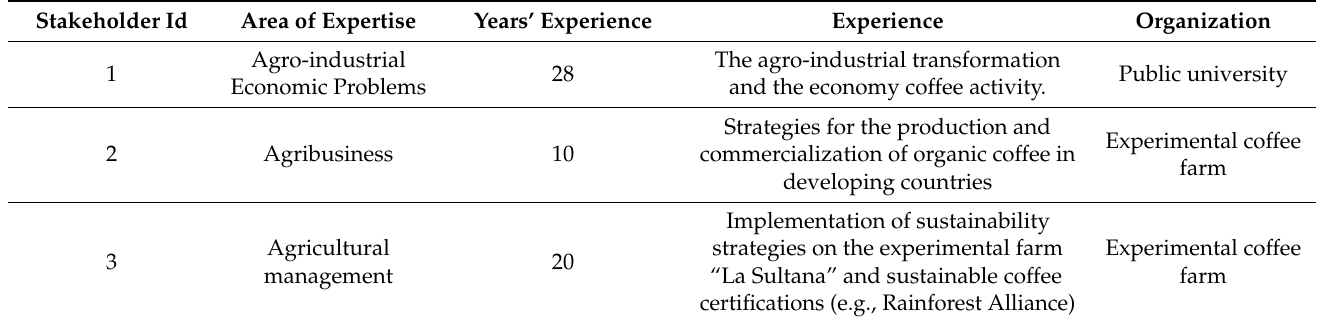
Table 1. The stakeholder’s team involved in the HMP-Coffee conception. Stakeholder Id: identifier of the expert. Area of expertise: Academic training of the members of the expert panel. Years’ experience: Number of years of experience working on topics associated with coffee. Experience: Work areas, and Organization: Academic and business organizations to which they